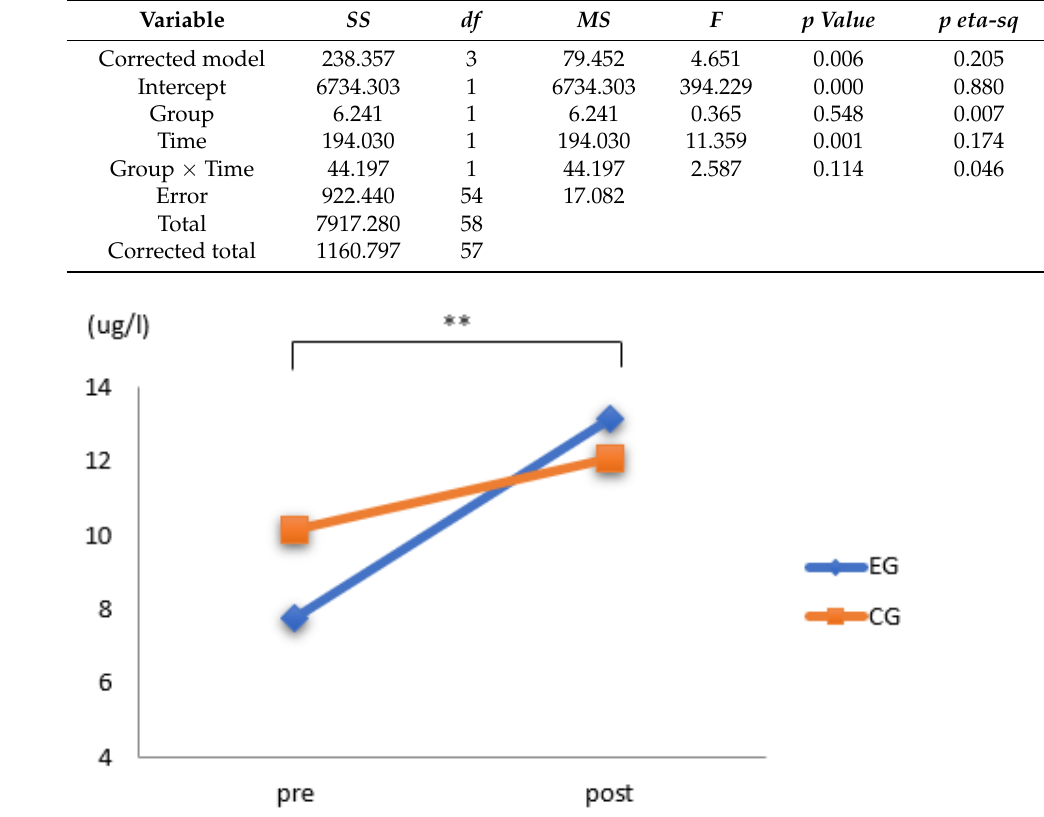
Table 5. Results of two-way ANOVA analysis of ALP.